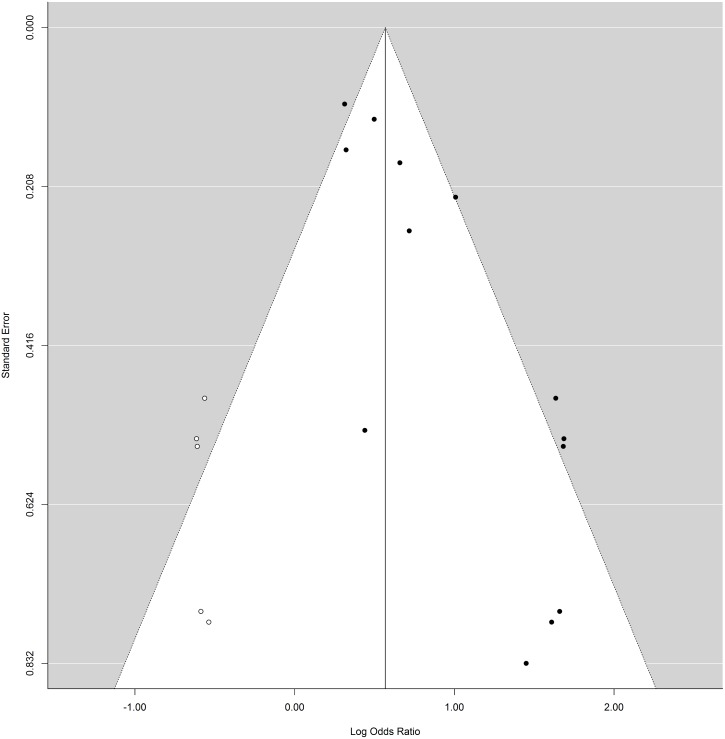
Trim-and-fill plot.